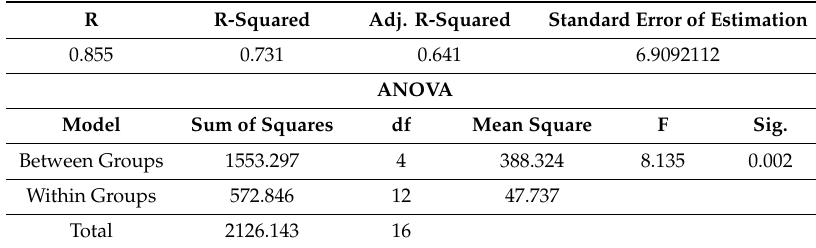
Table A1. R and ANOVA.